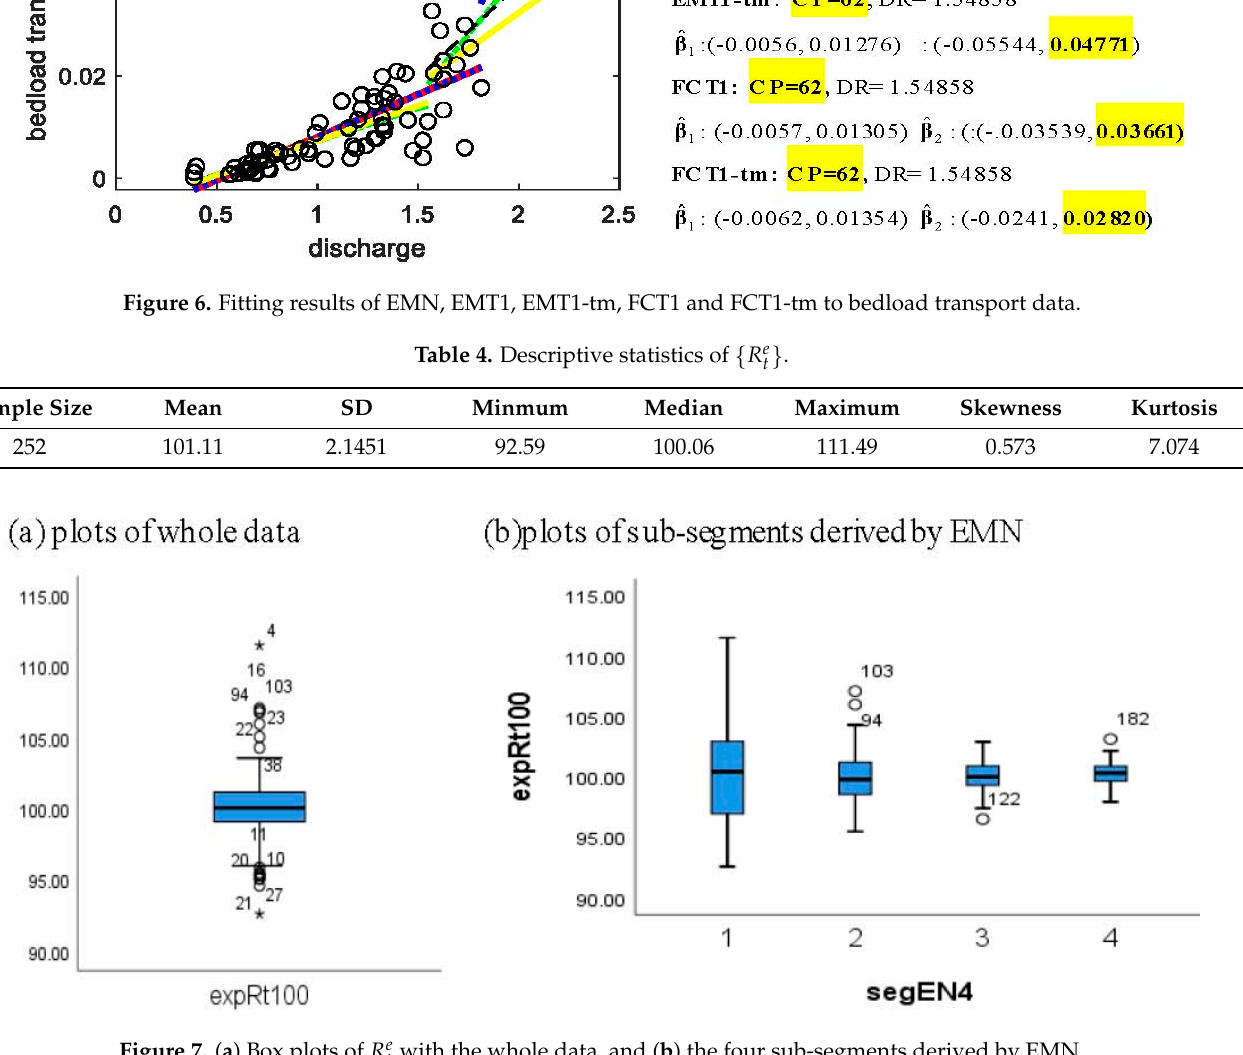
Figure 7. ( a ) Box plots of